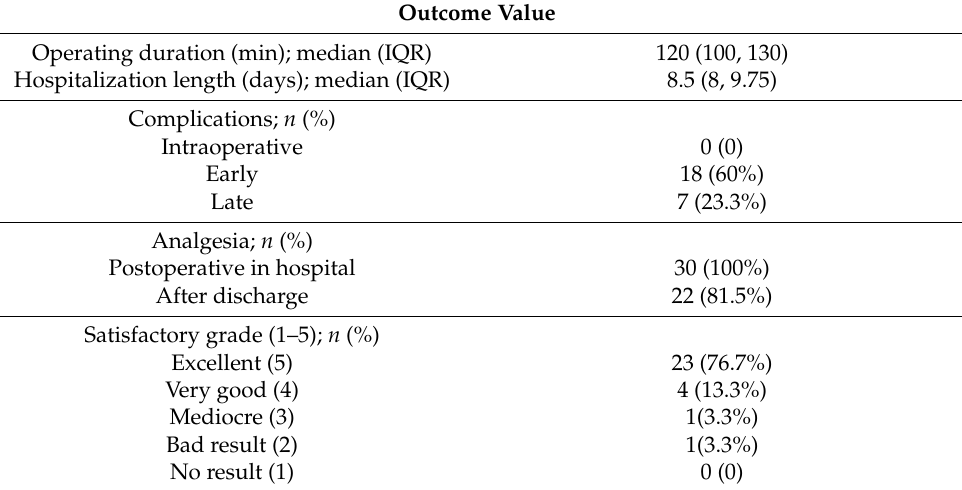
Table 2. Treatment